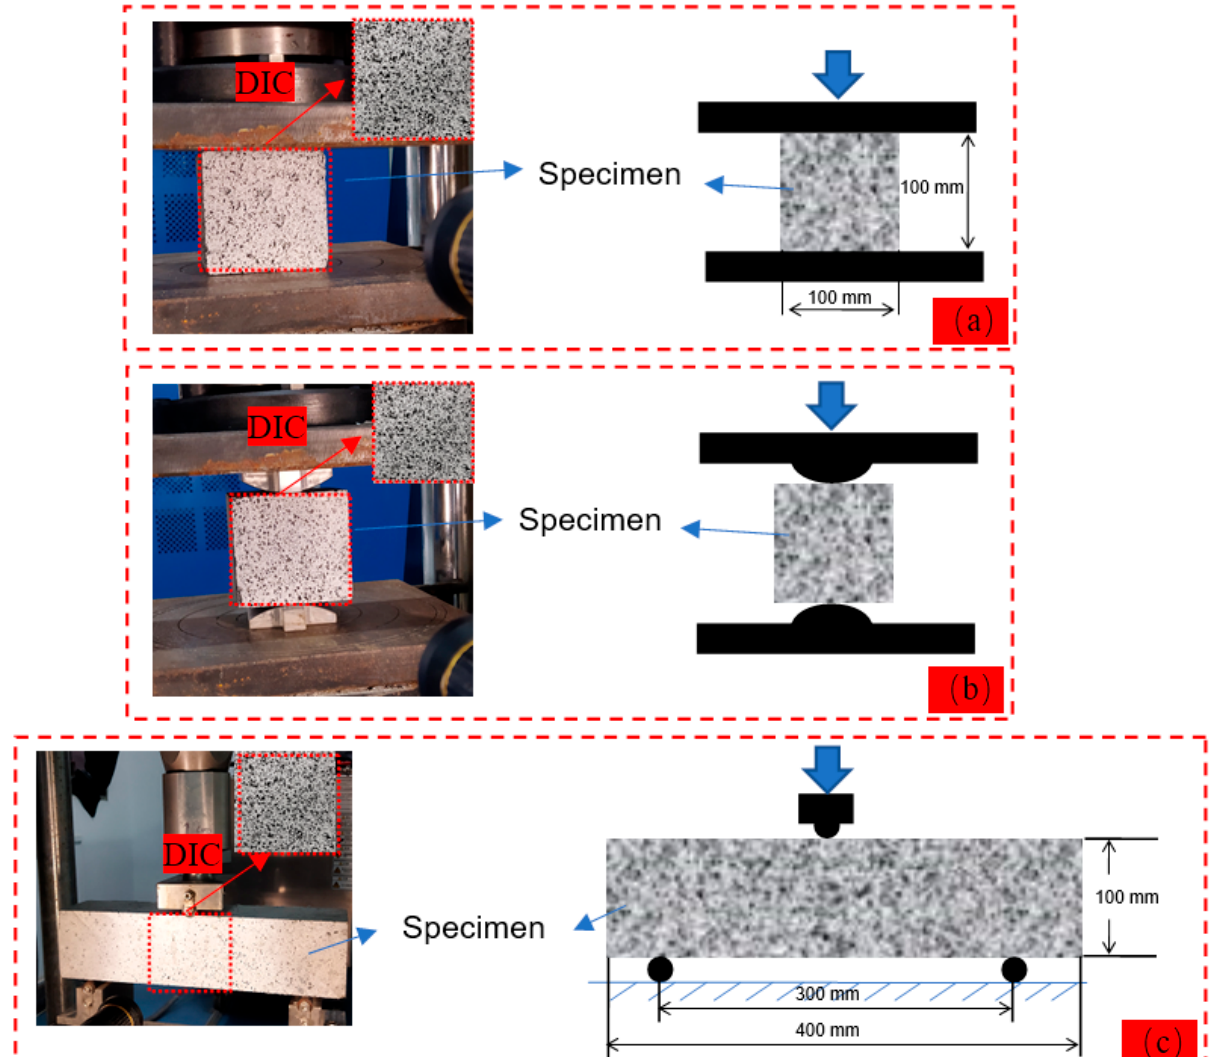
Figure 2. Test device of ( a ) compressive strength test, ( b ) splitting strength test, and ( c ) three-point bending test.